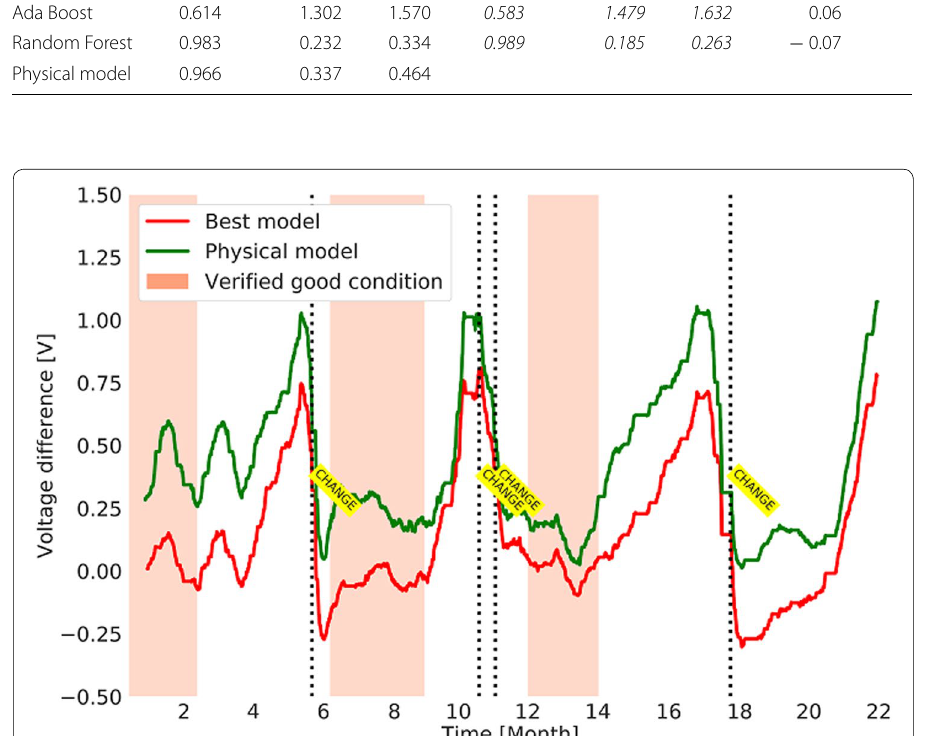
Fig. 8 A time series plot of the difference voltages (parasitic voltages) obtained from the best machine learning model (red), i.e. RF hybrid model and the physical model (green )for the complete data set, represented as median values. The dashed vertical lines with the highlighted text present times of anode changes. The time window for calculating the median is approximately 10 days before and after (rolling median). The orange shaded areas represent the “good segments” used for machine learning model training and validation. The unshaded areas represent “bad segments”, while some low voltage difference areas